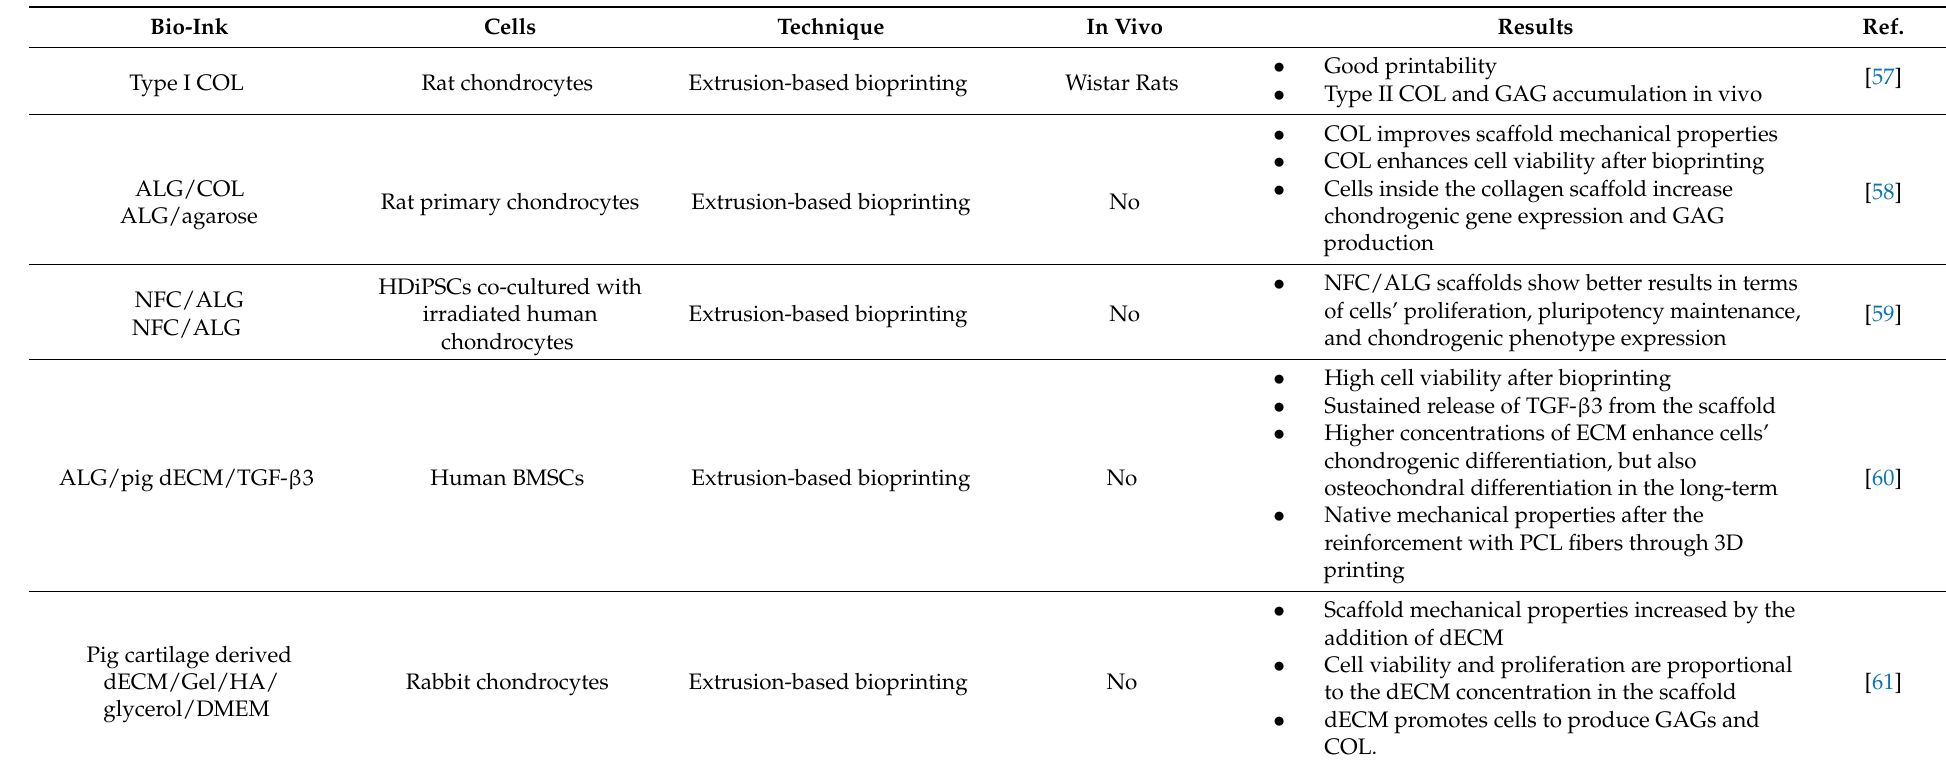
Table 2. Summary of the 3D bioprinting studies for